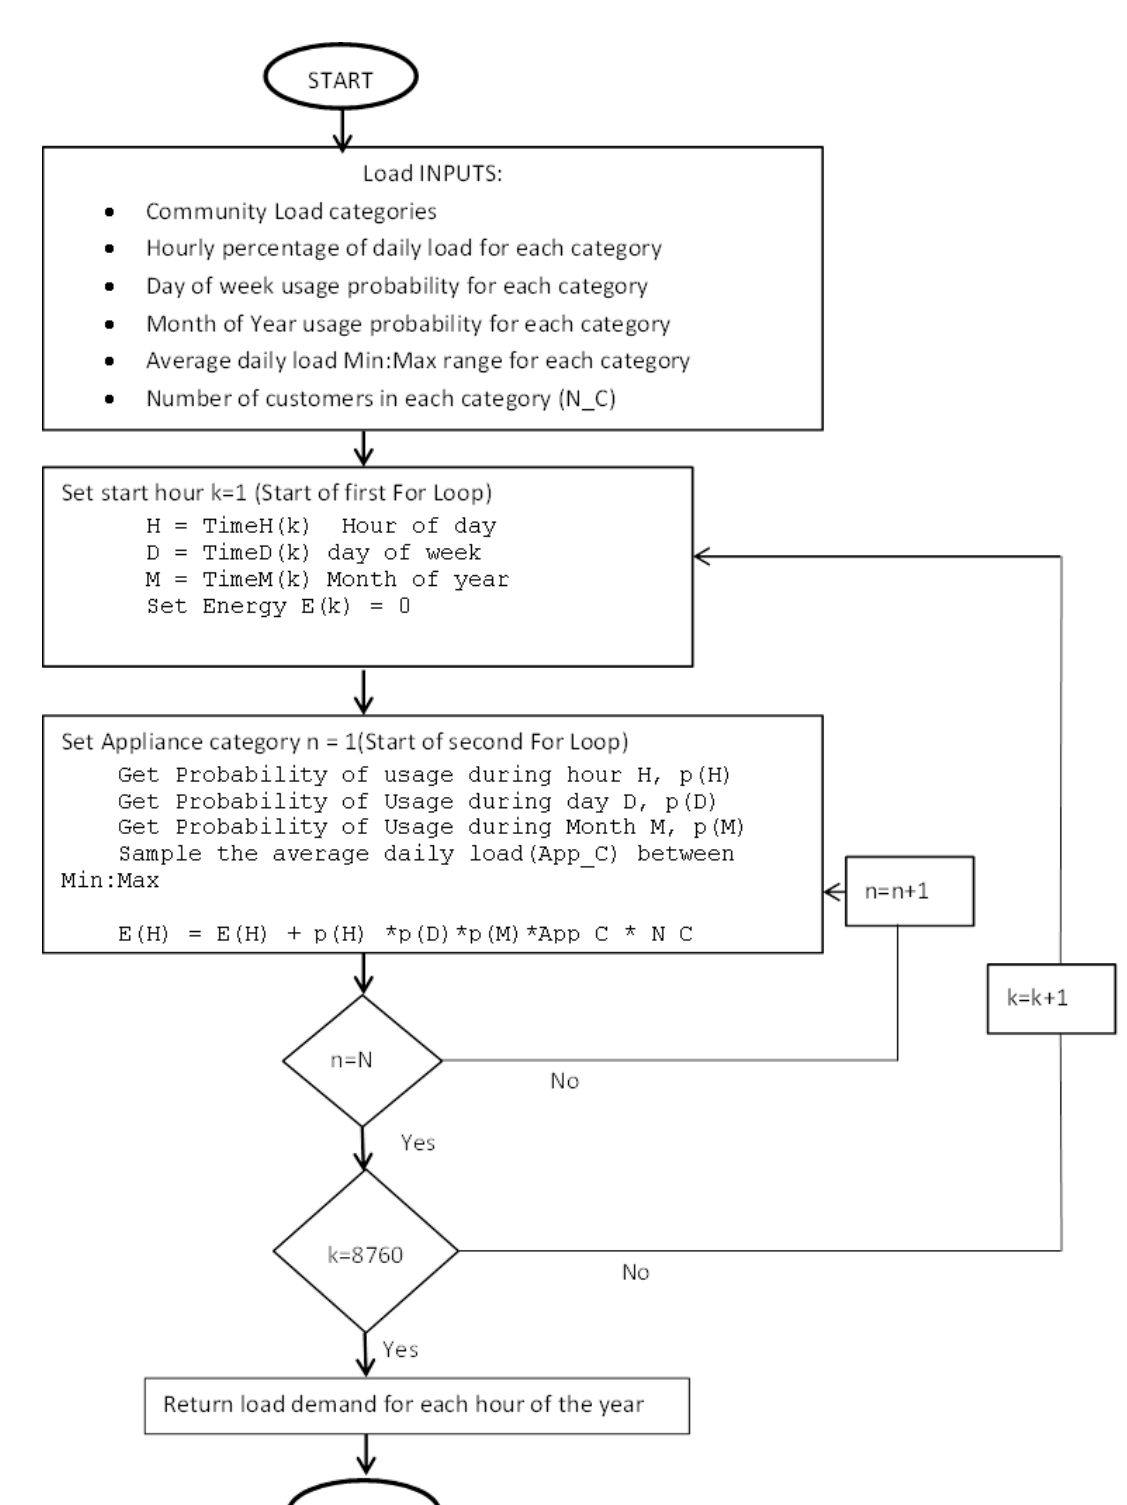
Figure 6. Flow chart for calculation of energy consumption at each